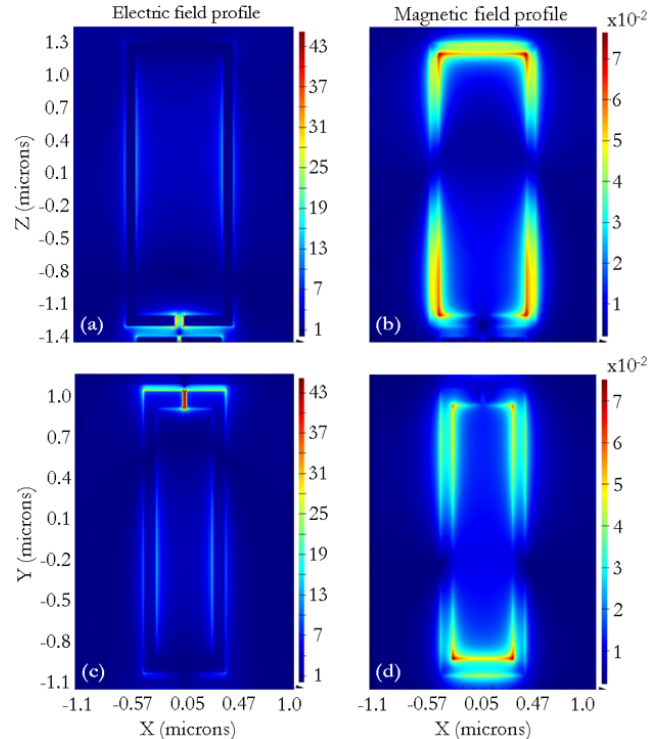
Figure 5. The ( a ) electric and ( b ) magnetic field profiles of the VSRR in V/m and A/m, respectively, are plotted at peak absorption. The ( c ) electric and ( d ) magnetic field profiles of the PSRR in V/m and A/m, respectively, are plotted at peak